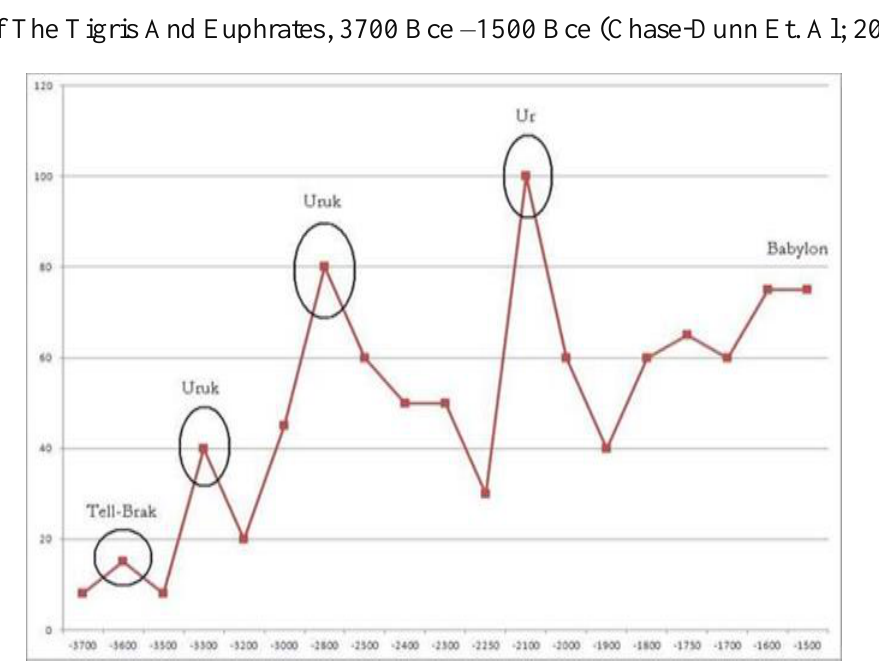
Figure 14. Urban Population (In Thousands) Of The Earliest Cities Found Nearest